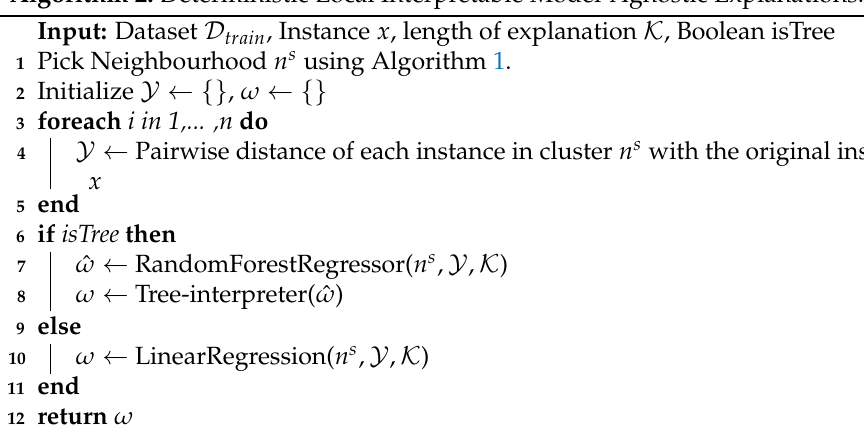
Algorithm 2: Deterministic Local Interpretable Model-Agnostic